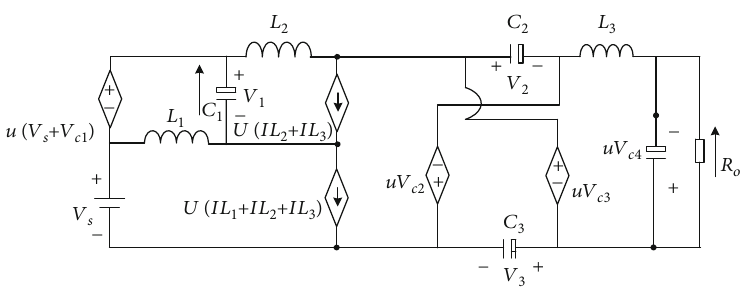
Figure 10: Average equivalent